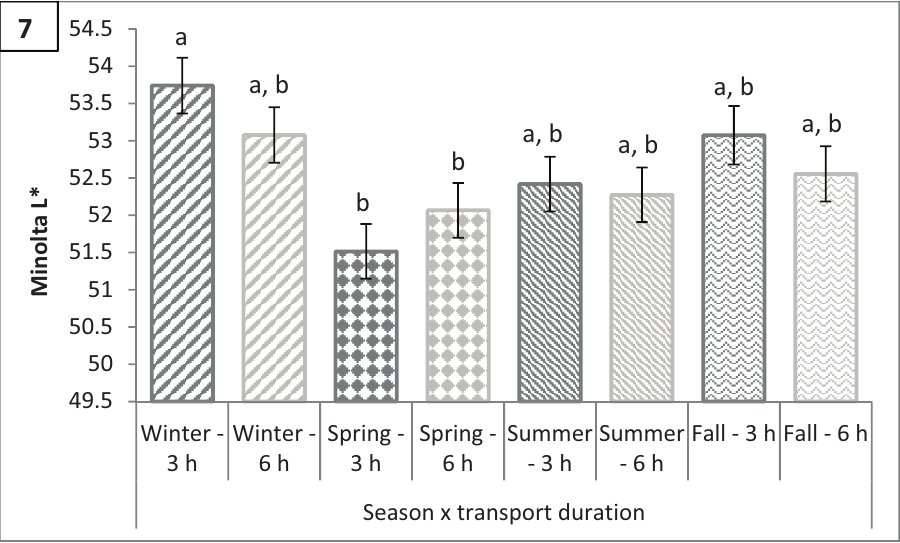
Figure 7. Minolta L* by season × transport duration (P = 0.0005). Values with different letters differ by P < 0.05.